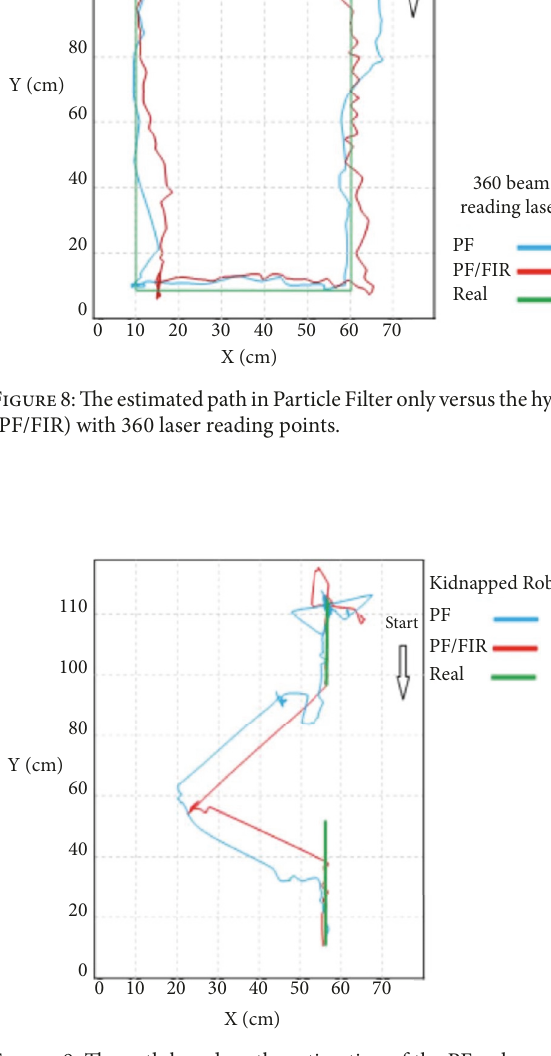
Figure 9: The path based on the estimation of the PF only and the hybrid filter.